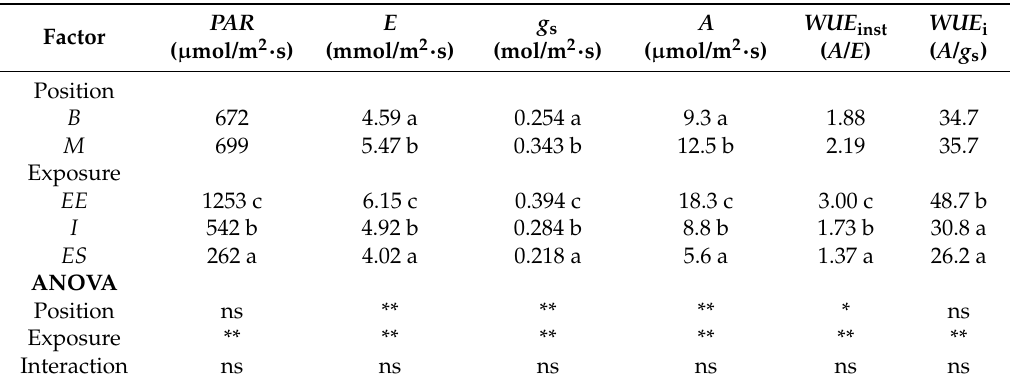
Table 3. Effect of leaf position ( B , M ) and exposure ( EE , I , ES ) on leaf gas exchange and water use efficiency. Data taken 29 May. B = basal; M = median; EE = exterior/exposed; I = interior; ES = exterior